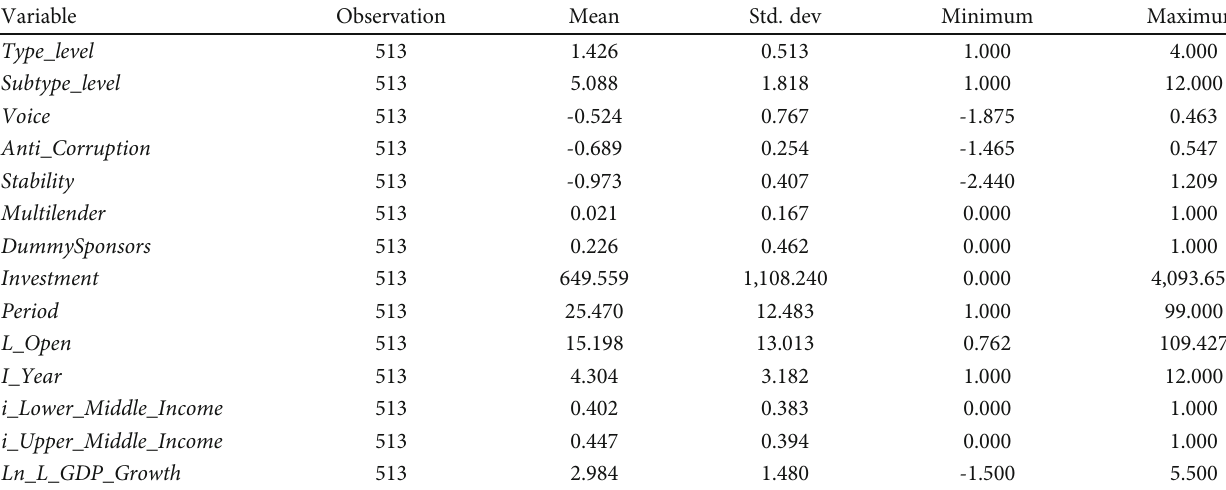
Table 7: Summary statistics of variables in regression model